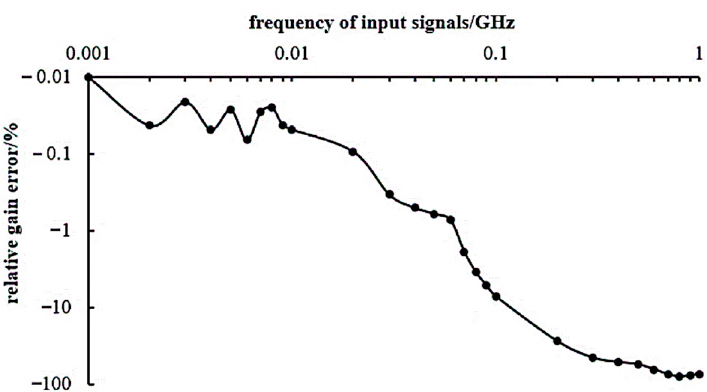
Figure 9. System frequency response.